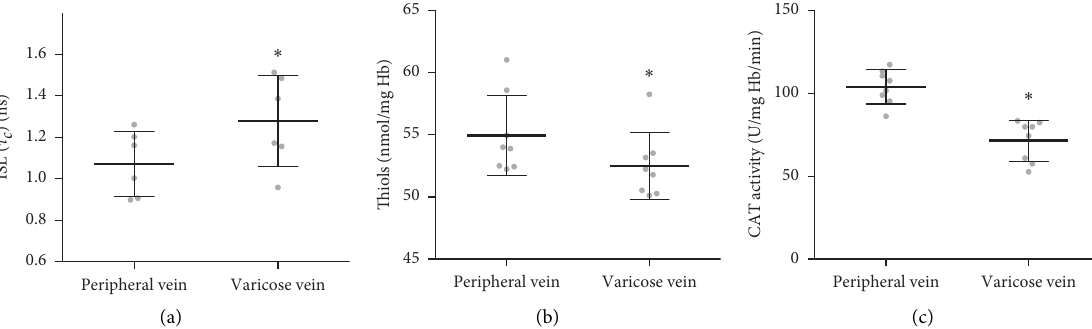
Figure 3: Mobility of ISL labeled hemoglobin (a), the levels of total thiols (b), and catalase activity (c) in the hemolysate obtained from a peripheral vein and a varicose vein. Data are shown as mean ± range of standard deviation, n � 8. ∗ p < 0 . 05 is the significant